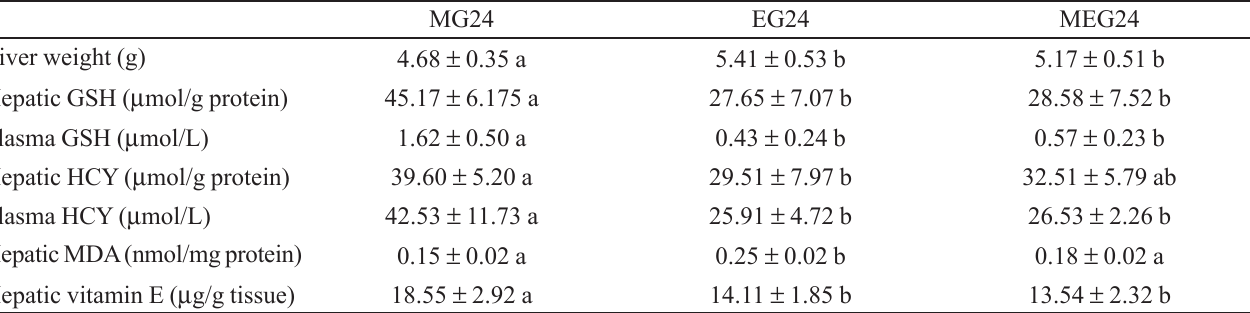
TABLE I - Biochemical data for the animals that received methionine and/or ethanol and were sacrificed 24 hours